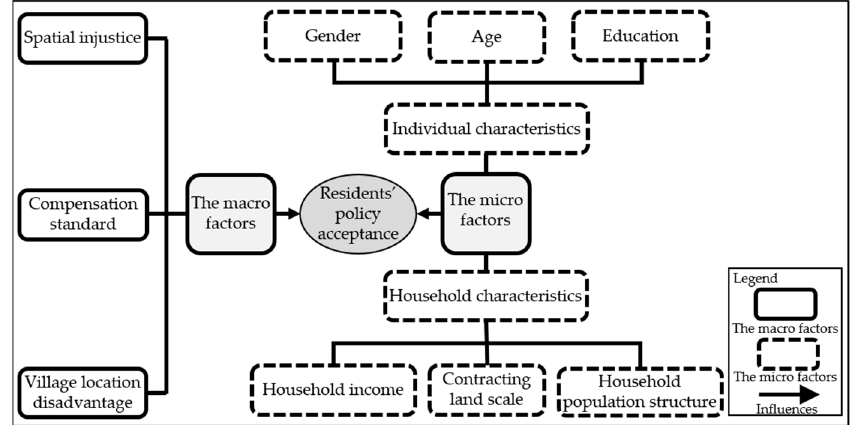
Figure 2. The empirical analysis framework of this study. Source: authors’ own work.